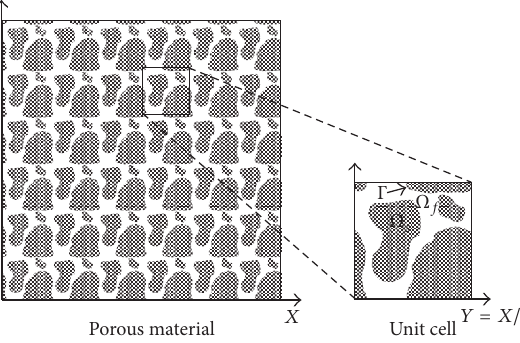
Figure 1: Sketch of porous media and unit